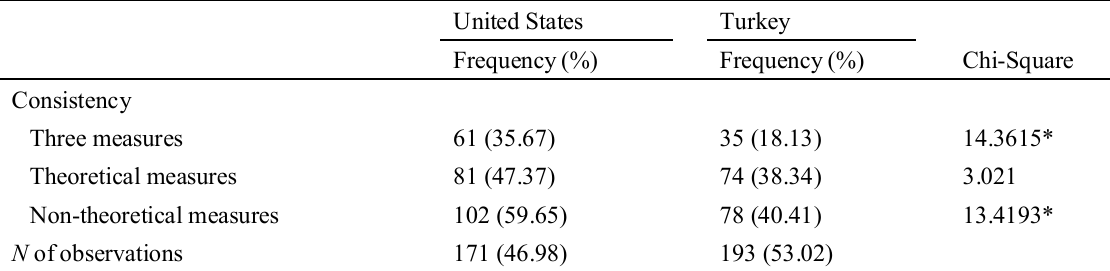
Table 3 . Frequency and Bivariate Analysis